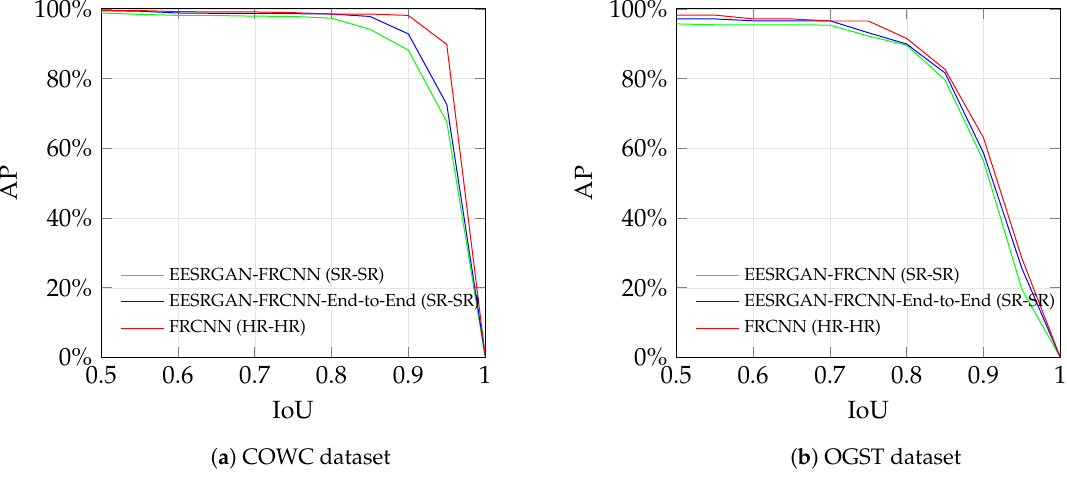
Figure 8. AP-IoU (average precision-intersection over union) curves for the datasets. Plotted results show the detection performance of standalone faster R-CNN on HR (high-resolution) images and our proposed method (with and without end-to-end training) on SR (super-resolution)